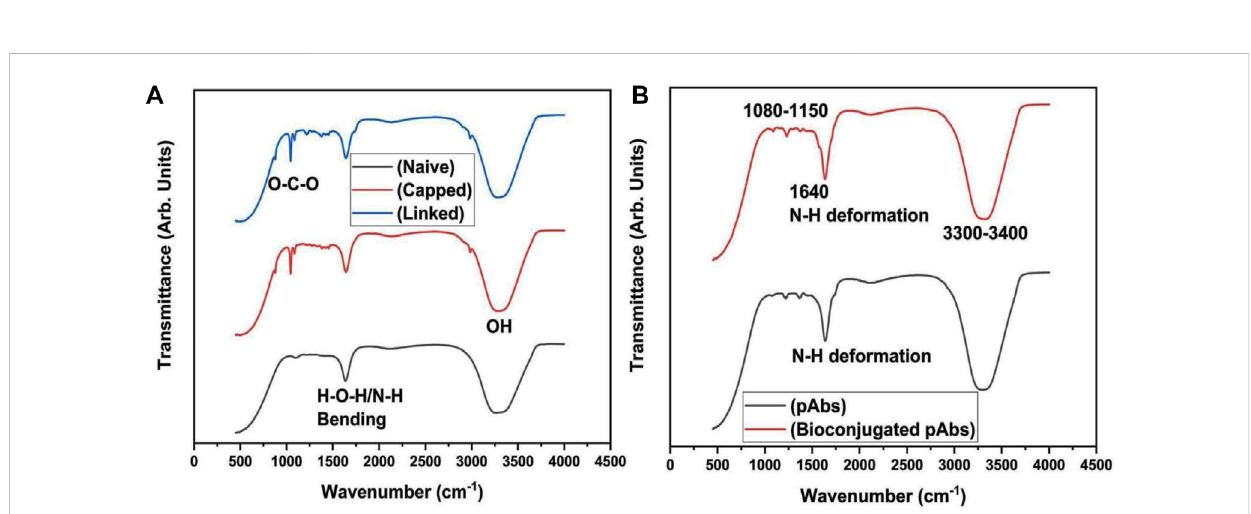
FIGURE 4 Characterization of AuNPs with (A) FT-IR analysis indicating N – H (3,300 – 3,400 cm − 1 ) stretching vibrations of amines, C=O (1,640 and 1,403 cm − 1 ), O – H (2,500 – 3,300 cm − 1 ), andS – H(2,600 – 2,550 cm − 1 )stretching ofamide, carboxylic, and thiolgroups,C – O(1,250 – 1,275 cm − 1 )stretching ofalkyl aryl group and – OH bending of alcohols along with C=C (1,643 cm − 1 ), C – H (1,382 and 2,983 cm − 1 ), N – O (1,505 cm − 1 ), and CO – O – CO (1,044 – 1,085 cm − 1 ) stretching of carboxylic, alkanes and alkyl groups, nitro, alcohols and anhydride groups at different absorption peaks for naive, capped, and